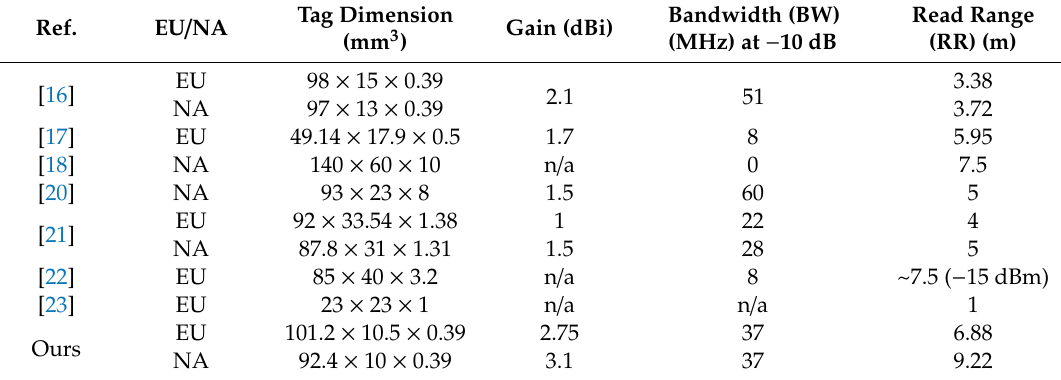
Table 4. Comparison of proposed tags with miscellaneous previously proposed tags. (n / a), not available. Required bandwidth (at S11 = − 10 dB) is 3 MHz and 26 MHz for European (EU) and North American (NA) UHF RFID bands [32],